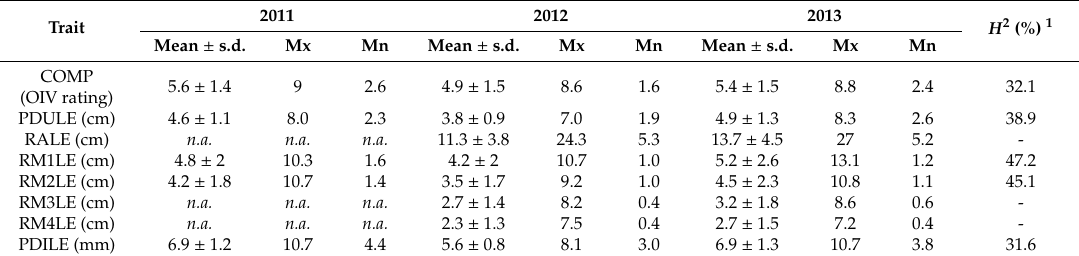
Table 3. Mean, standard deviation, maximum (Mx) and minimum (Mn) phenotypic values